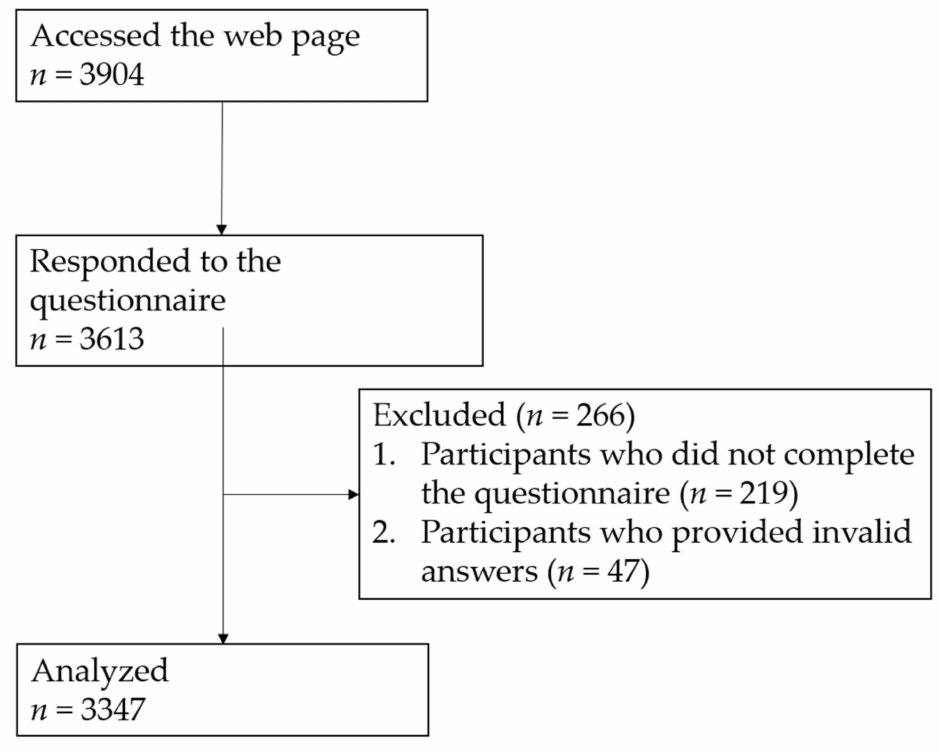
Figure 1. Subject flow